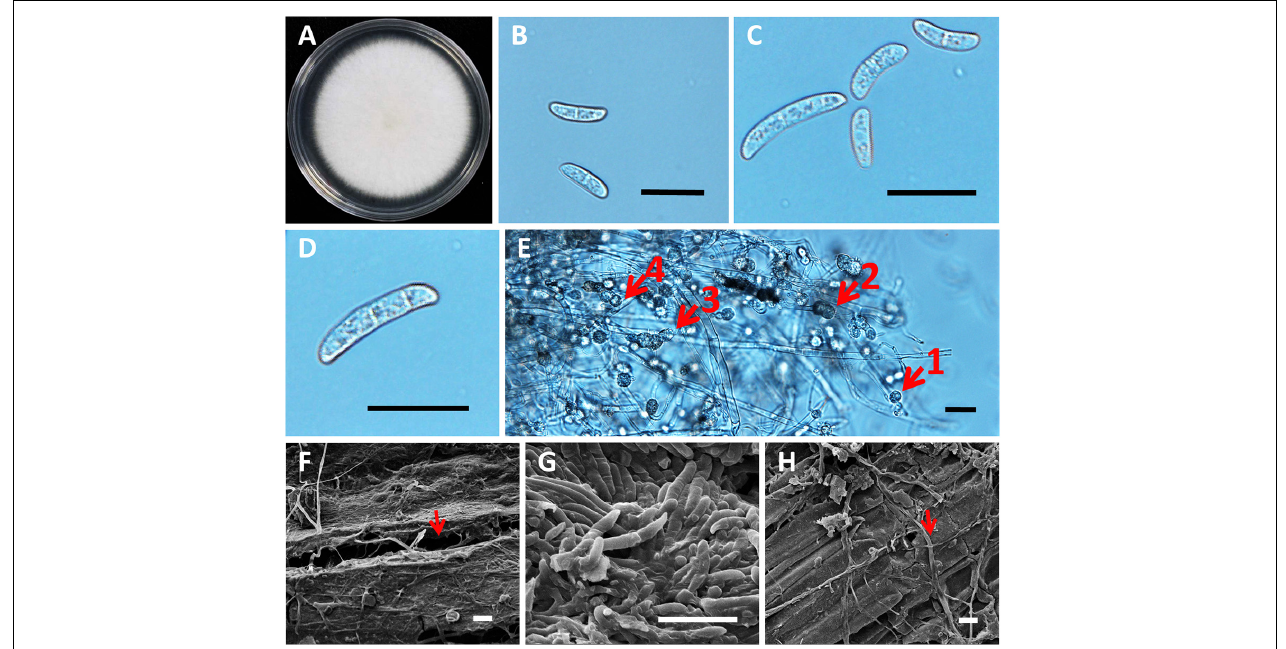
FIGURE 5 | Morphology of roselle wilt fungus, FsK1. (A) Colony on PDA medium with white to light cream color, irregular margins, and sparse aerial mycelia. (B) Microconidia were 13.46 ± 3.52 µ m × 4.46 ± 0.81 µ m, hyaline, oval to ellipsoid, with zero to one septum. (C) Microconidia and macroconidia. (D) Macroconidia were 30.9 ± 7.12 µ m × 5.95 ± 1.52 µ m, hyaline, straight to falciform with three to four septa, whereas apical cells were blunt, and the foot shape of the basal cell was poorly developed. (E) Chlamydospores were 10.38 µ m ± 2.94 µ m, hyaline or dark brown, oval to globose, one to four cells growing intercalary or terminally on the hyphae, and usually with oil droplets. The numbered red arrows indicate 4 different clusters with 1 to 4 chlamydospores grown on a single chain of the hyphae. (F) Opening in the root surface with hyphae (red arrow). (G) Surface of the stem base was colonized with hyphae and conidia of Fusarium spp. (H) Hyphae (red arrow), but not conidia, were observed in the rotten pith. Scale bar: 20 µ